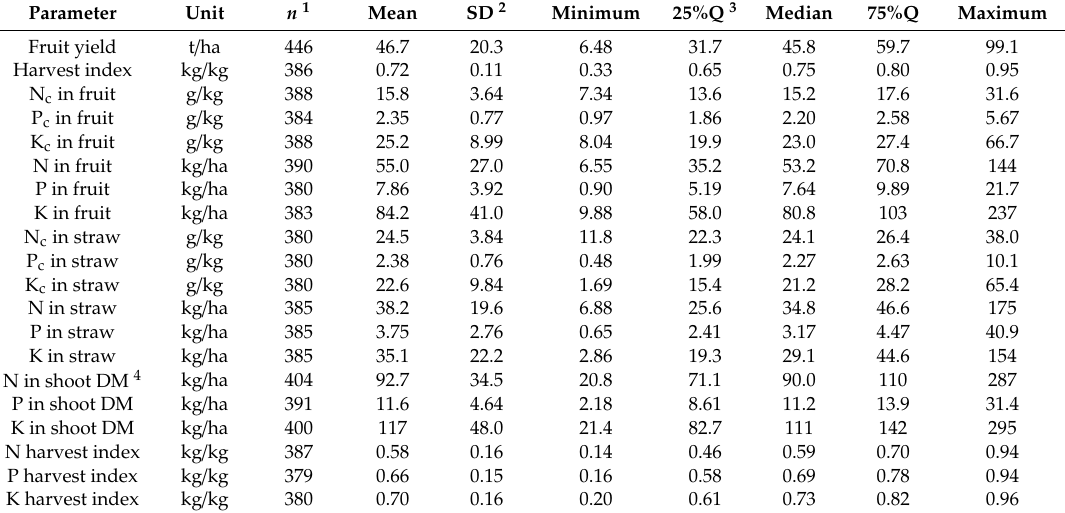
Table 4. Descriptive characteristics statistics of all watermelon data, including fruit yield, harvest index (HI), N, P and K accumulation in fruit, straw and shoot dry matter, concentrations of N (N c ), P (P c ), and K (K c ) in fruit and straw, and nutrient harvest index (kg nutrient in fruit per kg nutrient in shoot dry